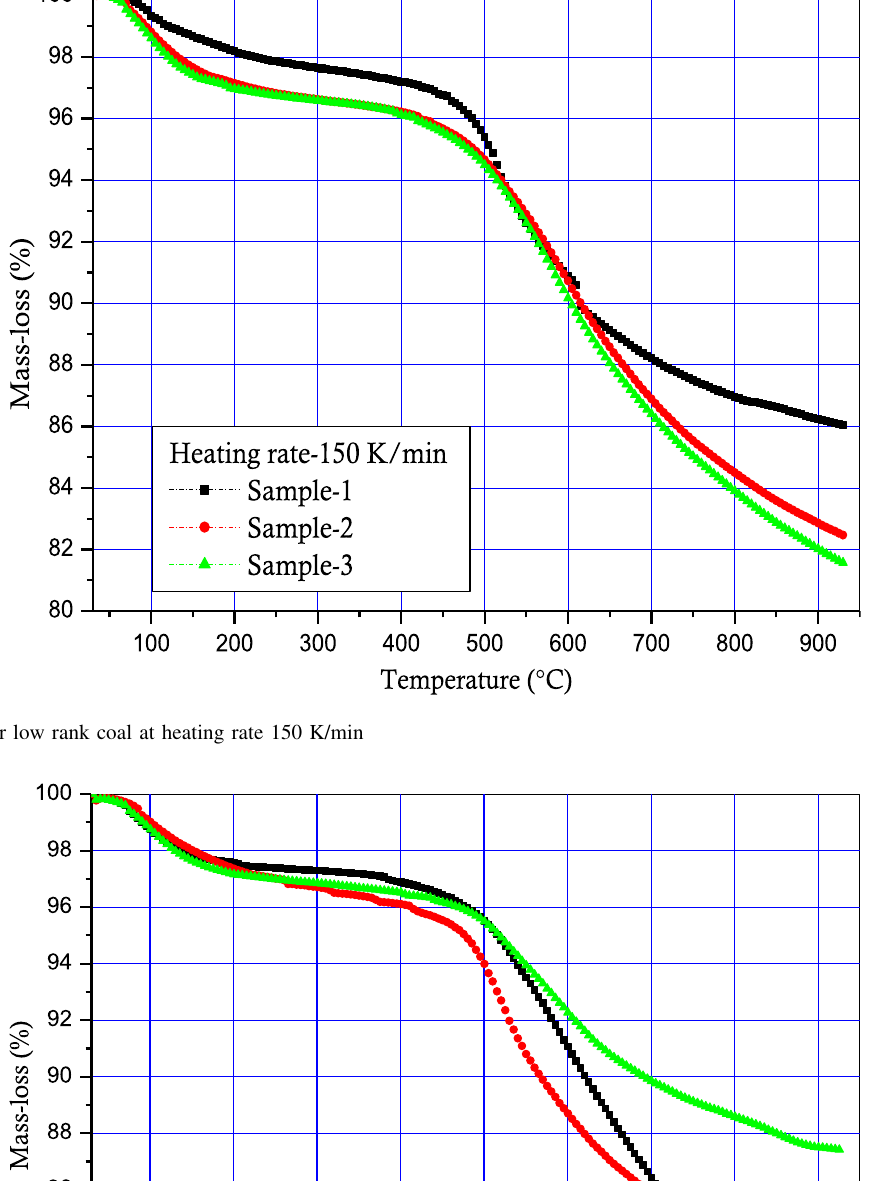
Fig. 4 TG curves for low rank coal at heating rate 200